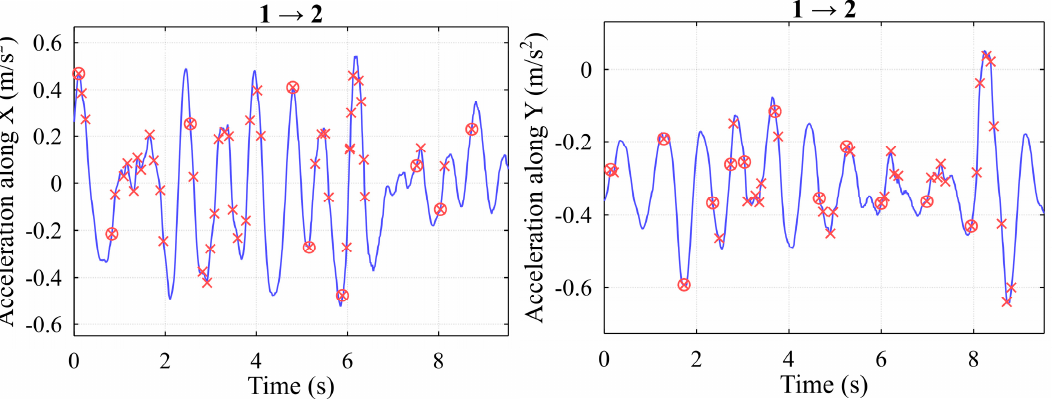
Figure 9. Use case No.1 with the standard IDM parameters (detected impacts: ( left ) 9; ( right ) 12).